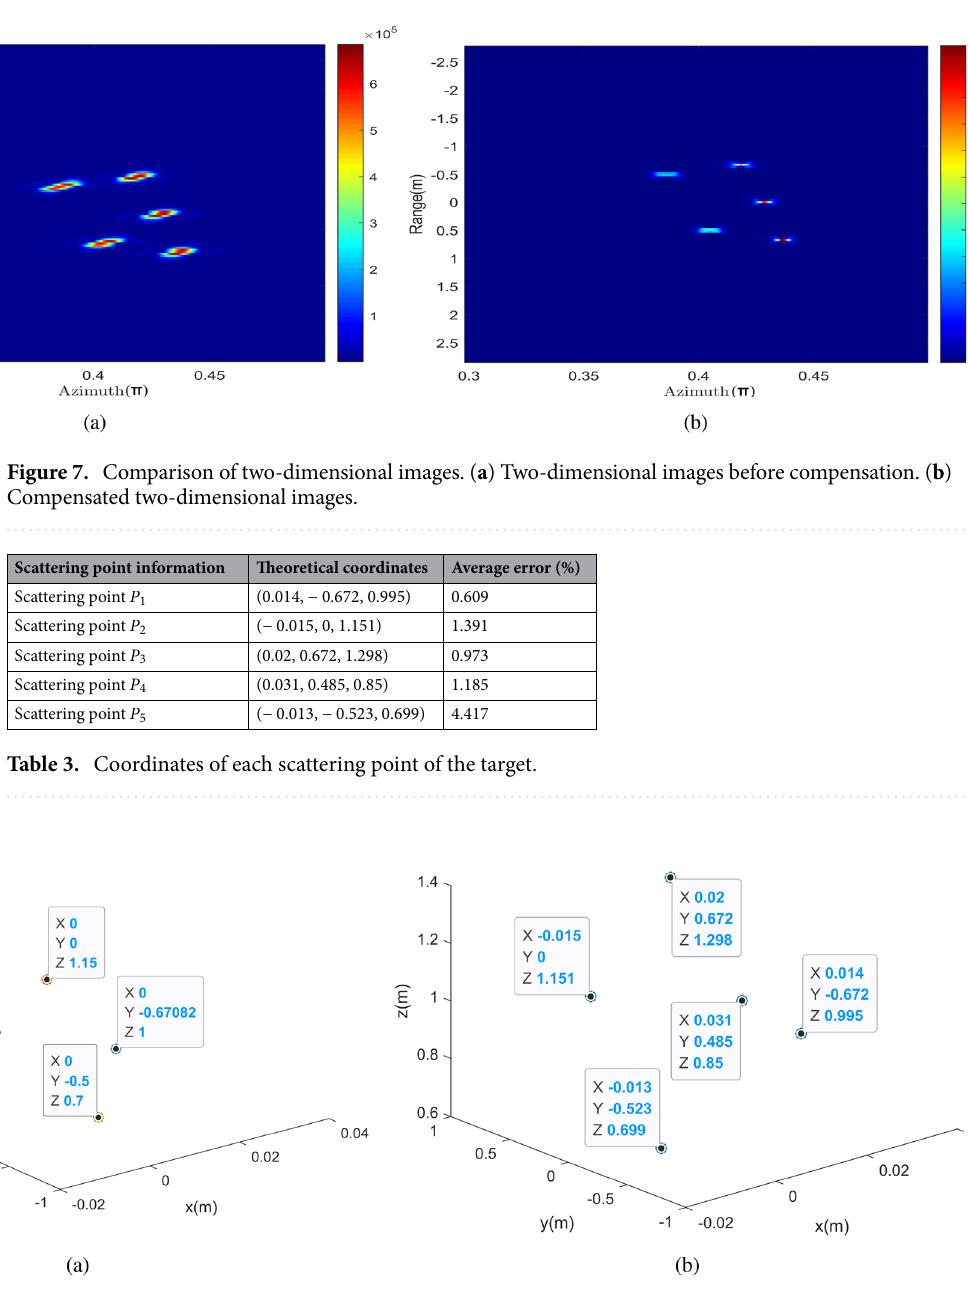
Figure 8. Comparison of 3D imaging results of point targets. ( a ) Ground truth. ( b ) Reconstructed imaging